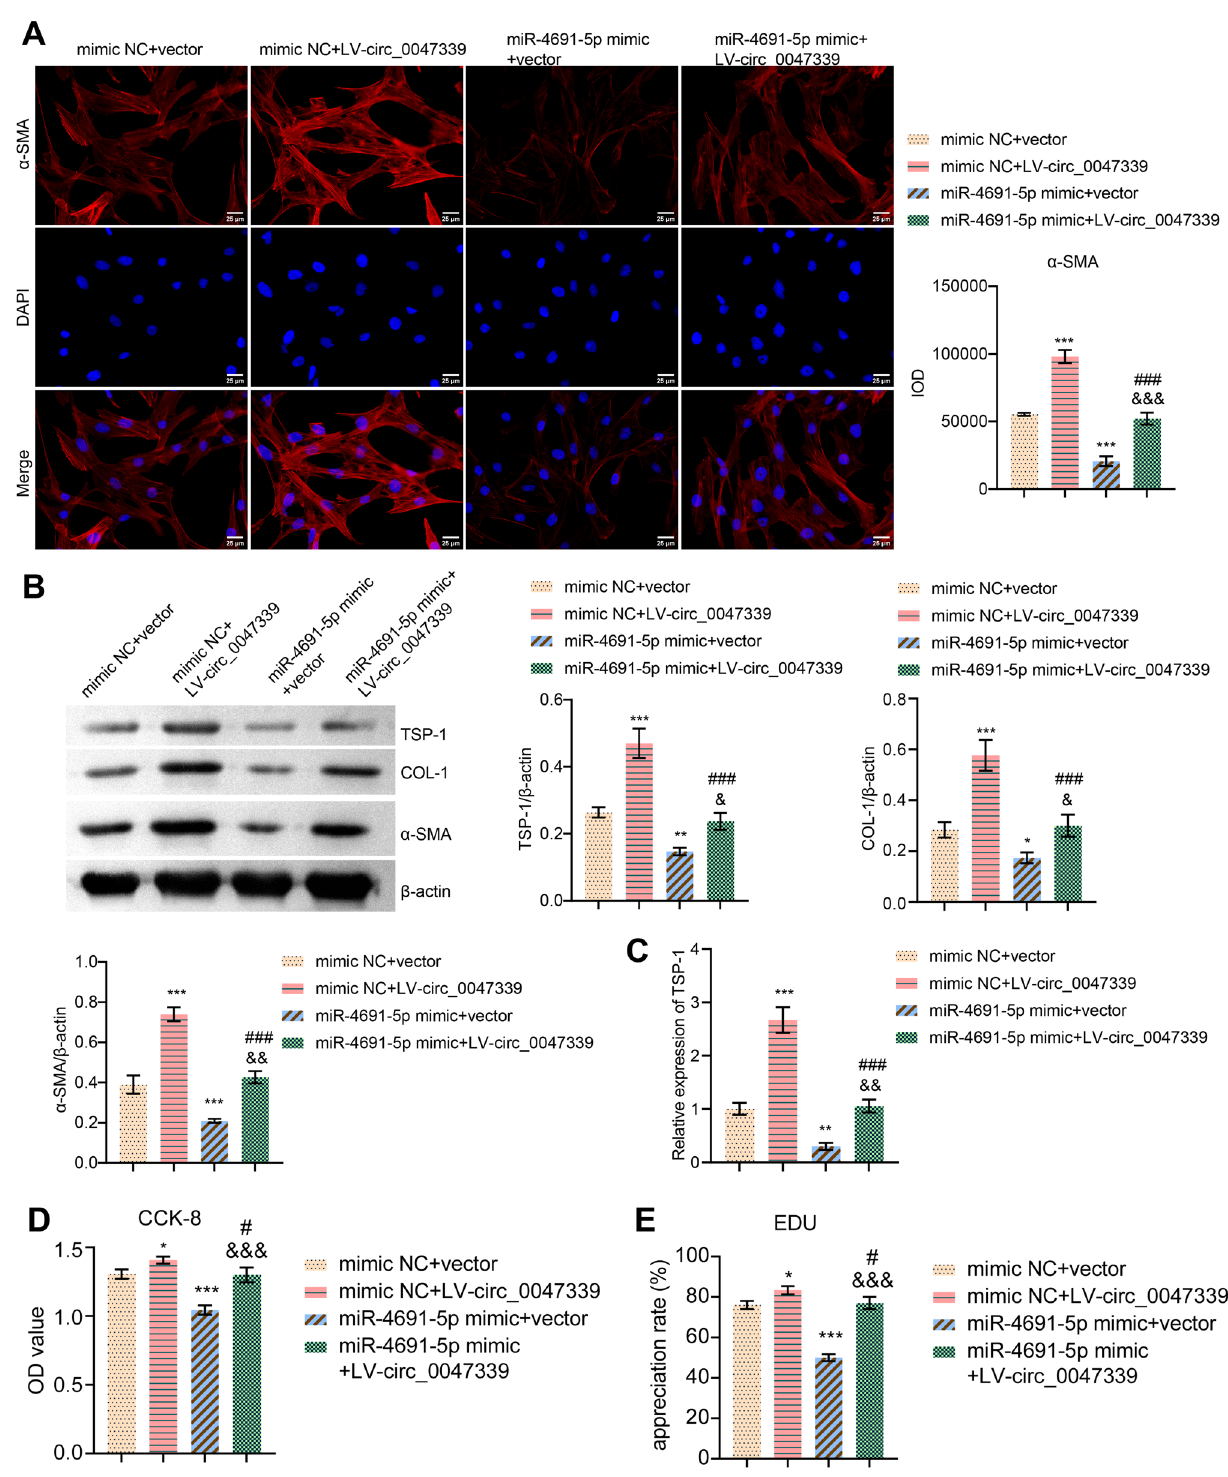
Figure 6. Circ_0047339/miR-4691-5p/TSP-1 interaction network regulated the proliferation, ECM deposition and collagen synthesis of urethral scar fibroblasts. ( A ) The expressions of α-SMA were evaluated by IF, scale bar: 25 μm. ( B ) The protein expression of COL-1, α-SMA and TSP-1 was tested by western blot. ( C ) RT-qPCR was used to assess the expression of TSP-1. ( D ) The cell viability was investigated by CCK-8. ( E ) EDU assay was used to investigate cell proliferation, scale bar: 50 μm. *P < 0.05, **P < 0.01, ***P < 0.001. VS mimic NC + vector group. # P < 0.05, ## P < 0.01, ### P < 0.001. VS mimic NC + LV-circ_0047339 group. & P < 0.05, && P < 0.01, &&& P < 0.001. VS miR-4691-5p mimic + vector